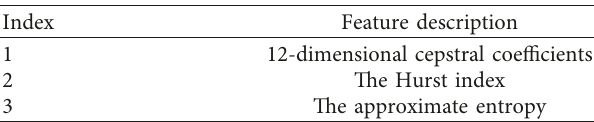
Table 2: Feature list.